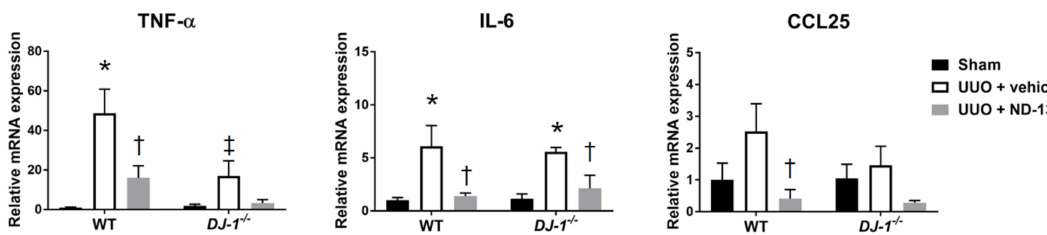
Figure 5. Expression of cytokine and chemokine genes associated with UUO is attenuated in kidneys obtained from WT mice treated with ND-13. Relative mRNA expression of cytokines TNF- α and IL-6 and chemokine CCL25 in renal cortex of WT mice and DJ-1 − / − mice that underwent sham surgery, UUO and vehicle treatment or UUO and ND-13 treatment. n = 4–5 / group; * p < 0.05 vs. same genotype sham, † p < 0.05 vs. same genotype UUO + vehicle, ‡ p < 0.05 vs. WT UUO + vehicle; two-way ANOVA with Tukey’s post-hoc